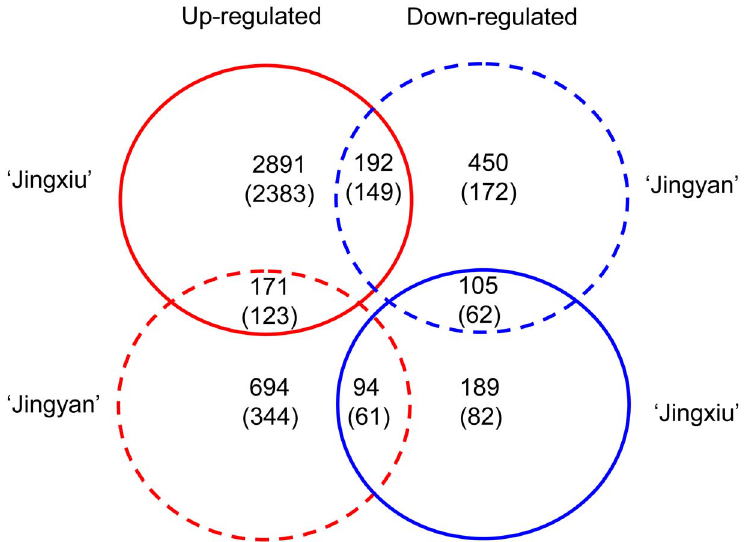
Figure 1. Numbers of differentially expressed genes with a log2 ratio $ 1 at P , 0.0001 in sunlight-excluded berry skin compared with sunlight-exposed berry skin for each cultivar. Solid- and dashed-line circles represent ‘Jingxiu’ and ‘Jingyan’, respectively. Red and blue circles represent up-regulated and down-regulated genes, respectively, relative to sunlight exposure. Numbers in parentheses indicate genes that exhibited a change in expression log2 ratio $ 2.